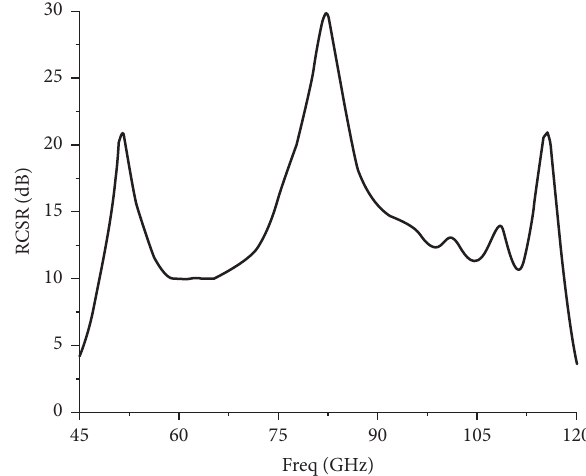
Figure 5: RCS reduction of capsule PCM array.